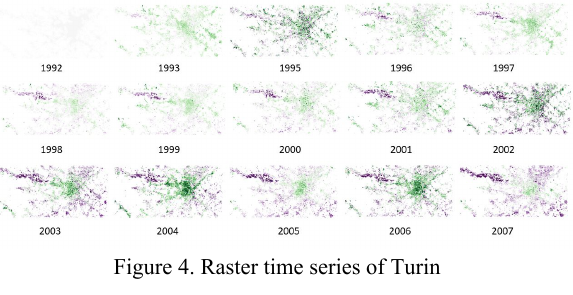
Figure 4. Raster time series of Turin